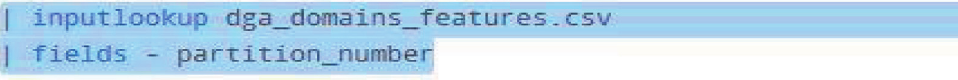
Figure 13: SPL commands for evaluating domain names based on specified properties.